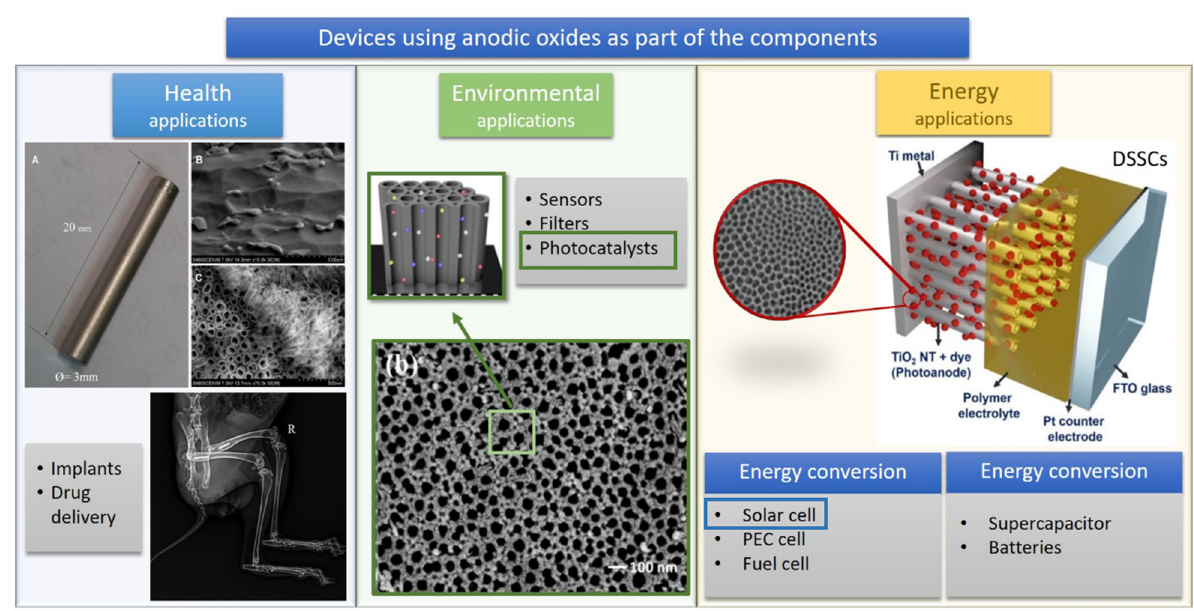
Scheme 1. Description of nanostructured anodic oxides in practical applications by the field. Figures used in this scheme were reprinted with permission from [14] and adapted from [15] and [16]. were reprinted with permission from [14] and adapted from